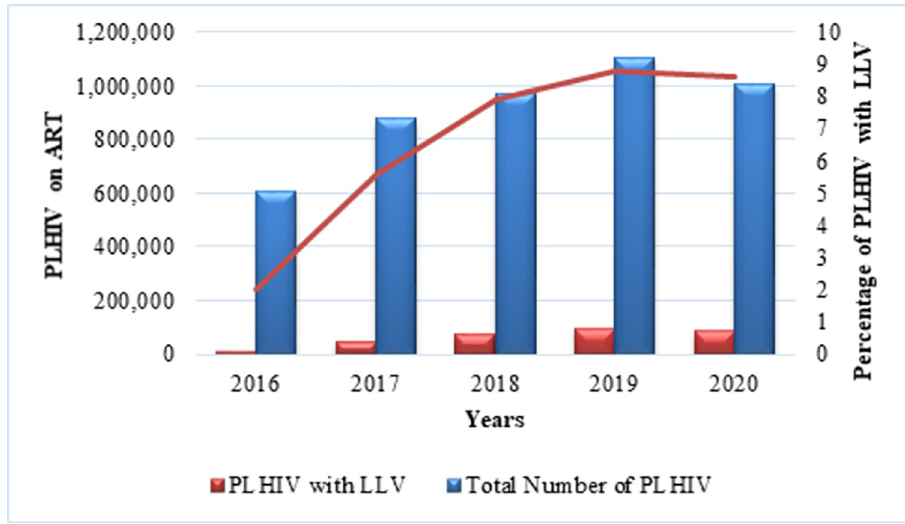
Fig 1. Graph showing the trend of low-level viraemia from 2016 to